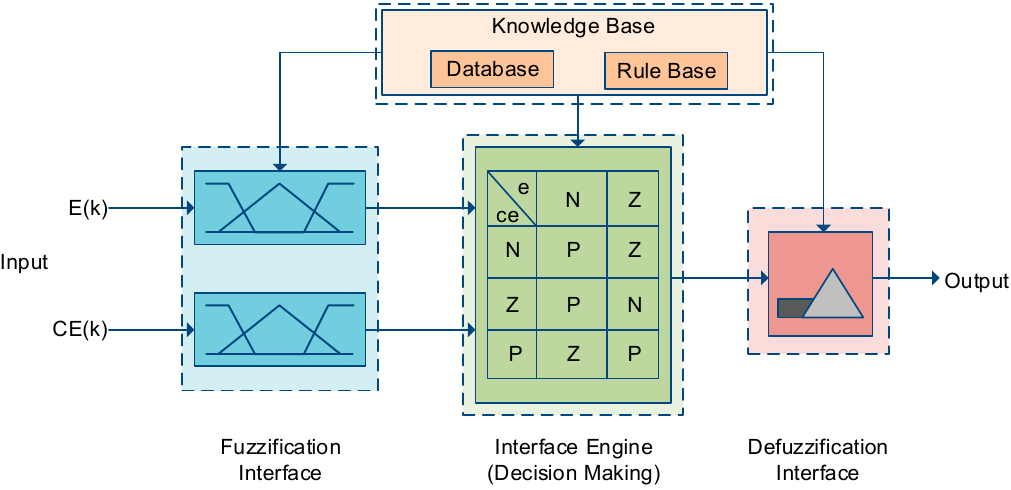
Figure 22. Fuzzy logic control block diagram.